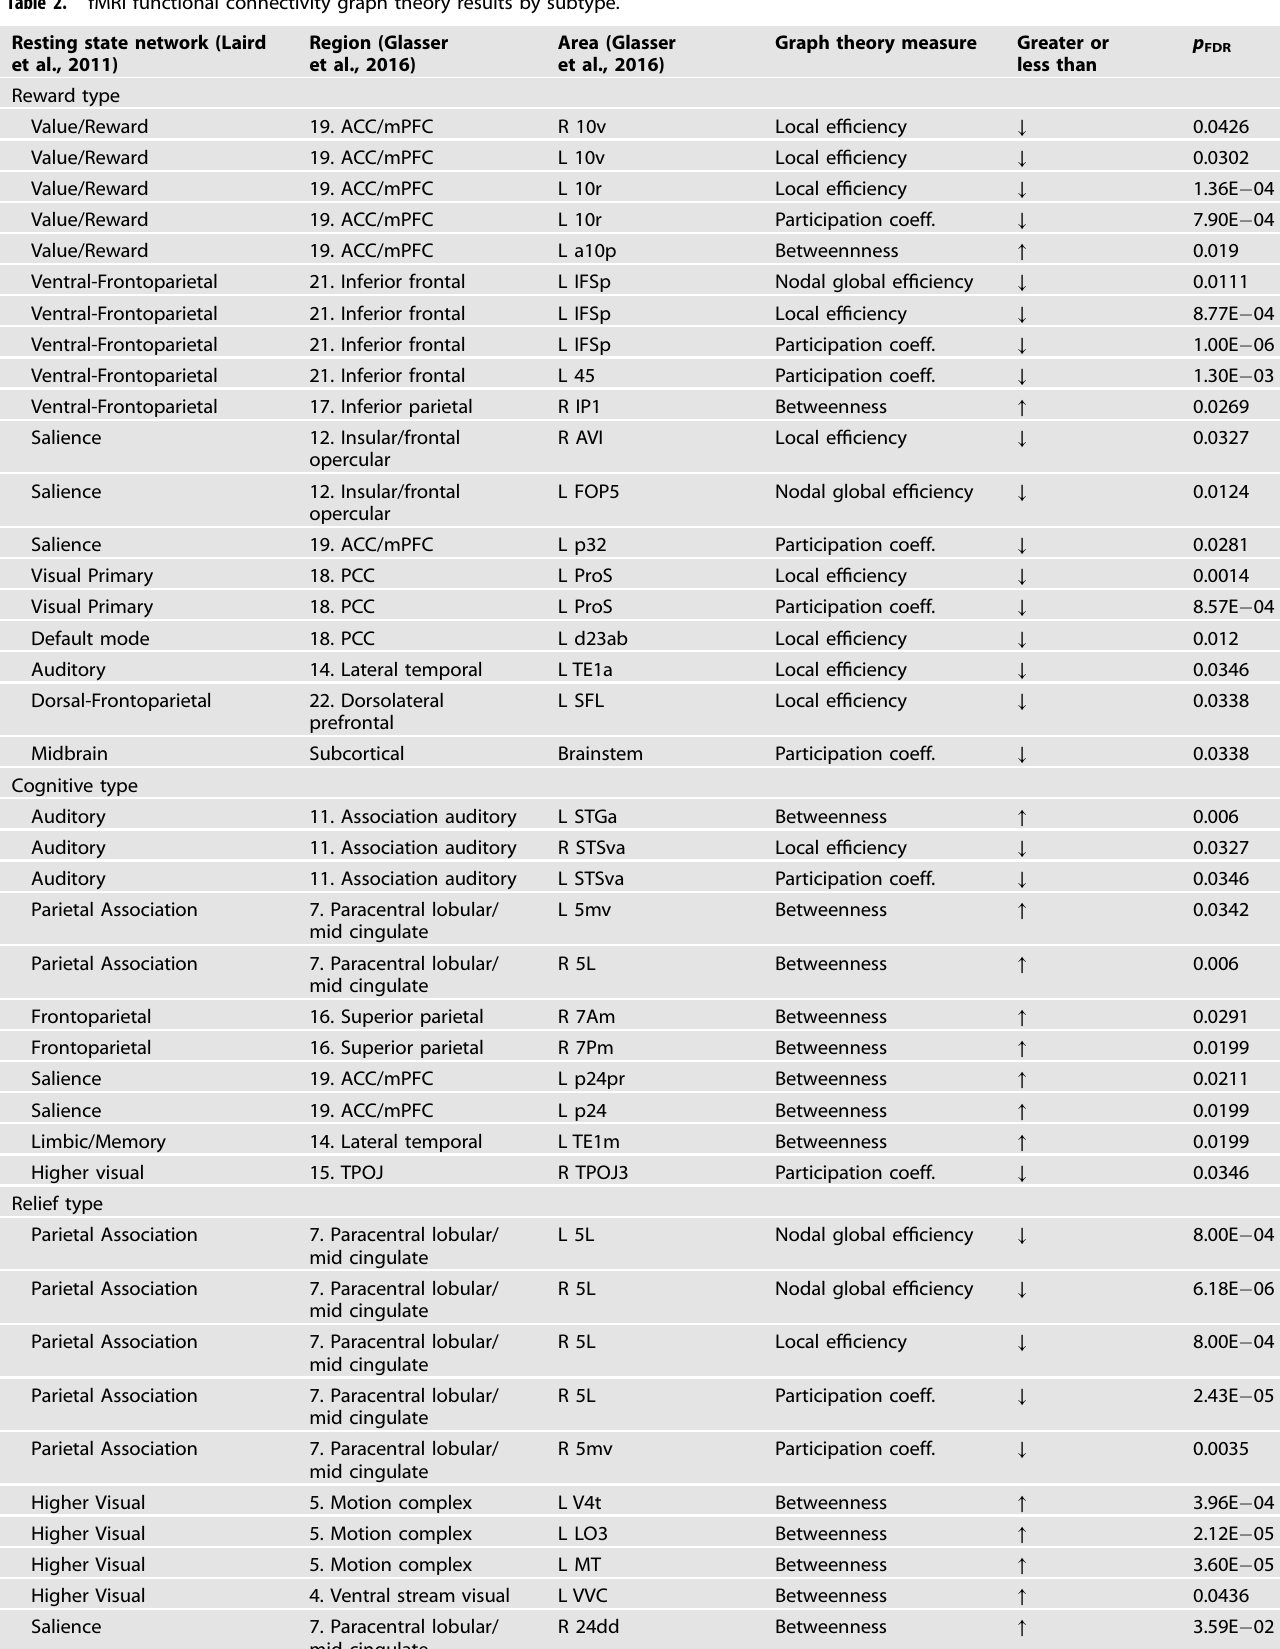
Table 2. fMRI functional connectivity graph theory results by